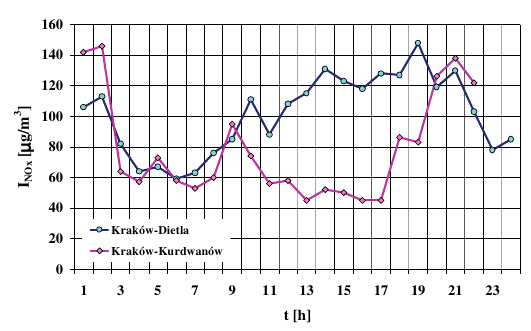
Fig. 12. The immission of nitrogen oxides on 6 January 2016